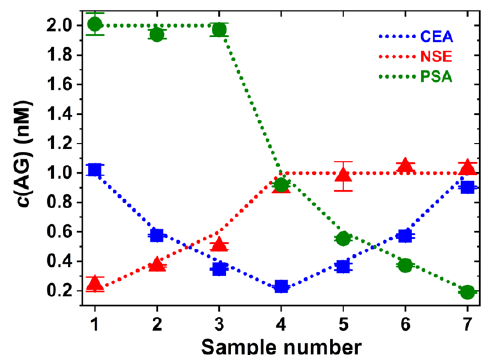
Figure 8. Identification of AG concentrations from samples with different concentrations of CEA, NSE, and PSA by triplexed FRET immunoassay. Dotted lines show the known AG concentrations. AG concentrations of the data points were determined from the triplexed calibration curves in Figure 7. Error bars resulted from triplicate measurements.